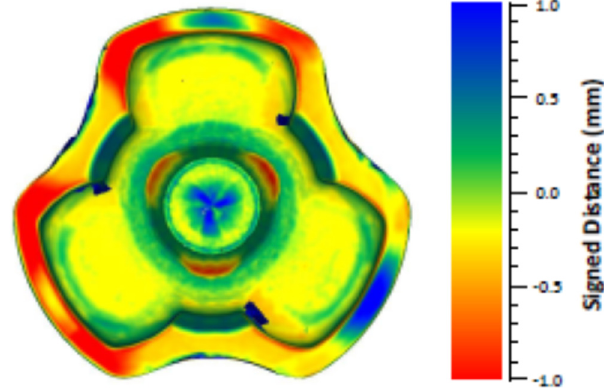
Fig. 2. Visual Dimensional Inspection of a forged workpiece using 3D reconstruction and mesh registration